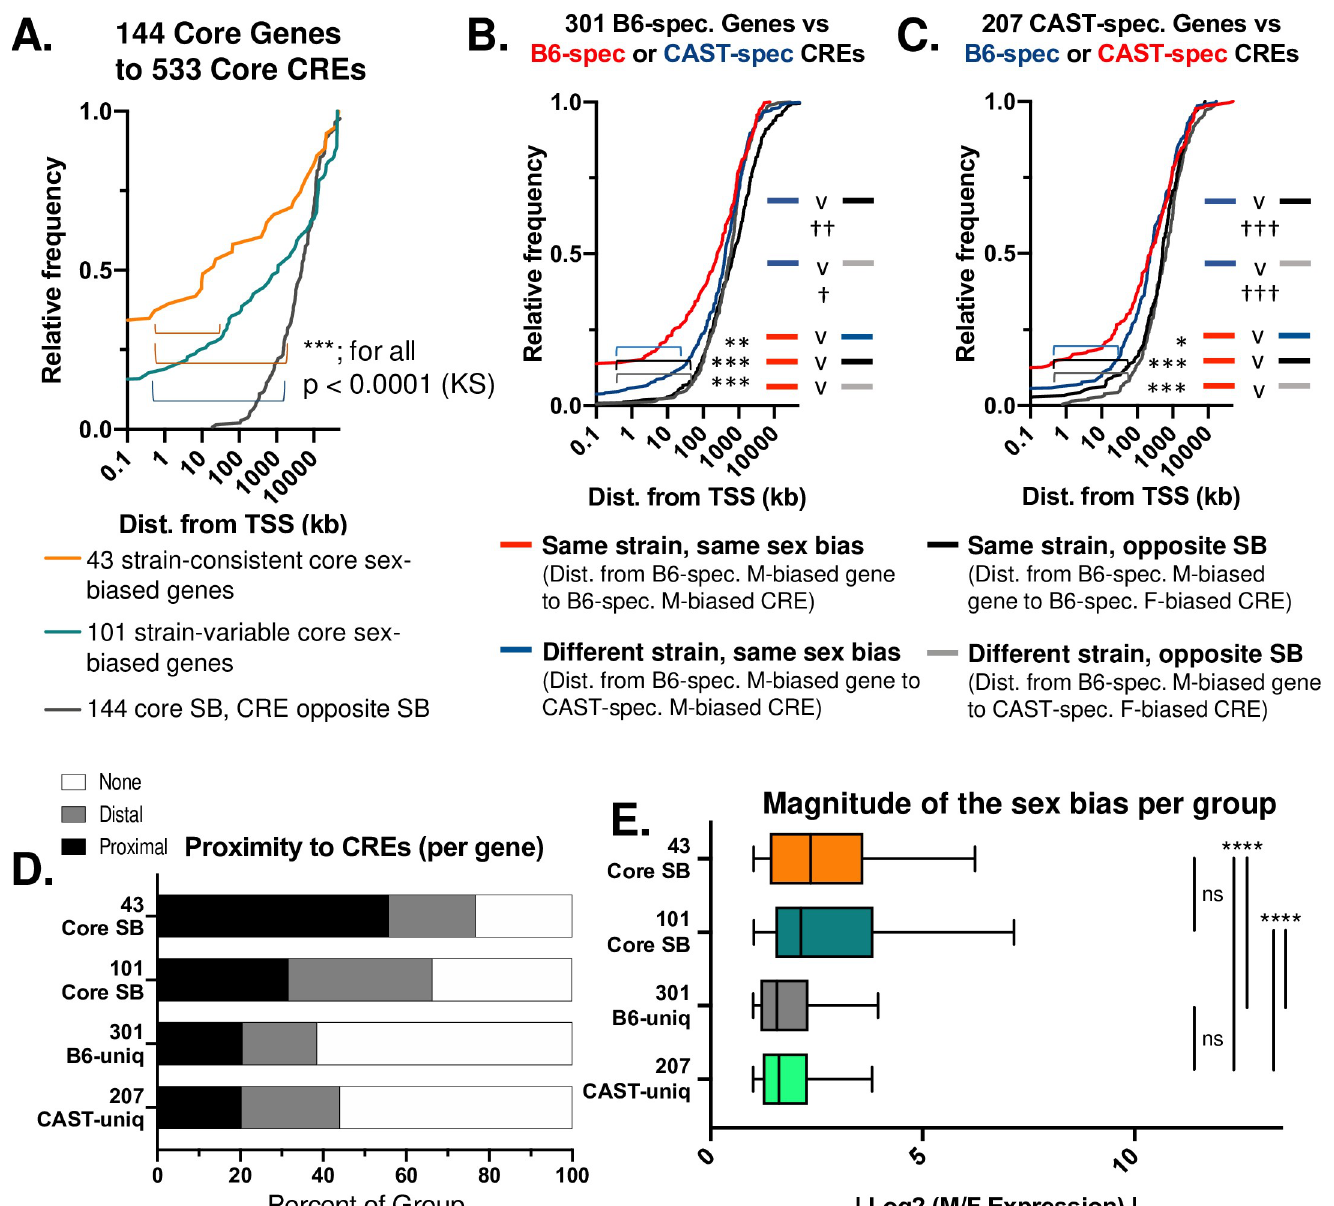
Fig 3. Strain-shared and strain-unique sex-biased cis regulatory elements. A. Cumulative frequency plots of distance from TSS of each gene set to the nearest core, strain-conserved sex-biased CRE with the same sex bias (i.e., distance from TSS of male-biased gene to the nearest male-biased DHS or male-biased H3K27ac peak). Plots are shown for 3 gene sets: 43 core sex-biased genes with strain-conserved expression (Fig 1B clusters MA or FA; orange), 101 core sex-biased genes with strain- variable expression (core sex-biased genes not in Fig 1B clusters MA or FA; teal), and the distance from all 144 core, strain-conserved sex-biased genes to the nearest sex-opposite CRE (e.g. distance from male-biased gene TSS to the nearest female-biased DHS or female-biased H3K27ac peak; gray). See also Sheet A in S1 Table. Significance was assessed by KS test: � , p < 0.05; �� , p < 0.01; ��� , p < 0.001; ns (not significant), p > 0.05. B. Cumulative frequency plot of distance from TSS of the 301 B6-unique sex-biased genes to four lists of cis regulatory elements (sex-biased DHS and sex-biased H3K27ac peaks): (1) B6-specific sex-biased CREs with the same sex-bias (as in panel A), in red; (2) CAST-specific sex-biased CREs with the same sex-bias, in blue; (3) B6-specific sex-biased CREs with opposite sex-bias, in black; (4) CAST-specific sex-biased CREs with opposite sex-bias, in gray. See Sheet C in S1 Table for B6-unique sex-biased genes. Significance, as in A. v, versus. C. Cumulative frequency plots of distance from TSS of 207 CAST-unique sex-biased genes to four lists of CREs (sex-biased DHS or sex-biased H3K27ac peak): (1) CAST-specific sex-biased CREs of the same sex-bias (as in A), in red; (2) B6-specific sex-biased CREs of the same sex-bias, in blue; (3) CAST-specific sex-biased CREs of the opposite sex-bias, in black; (4) B6-specific sex-biased CREs of the opposite sex-bias, in gray. See Sheet D in S1 Table. Significance, as in A. D. Core, strain conserved sex-biased genes are more proximal to similarly sex-biased CREs than strain-unique sex-biased genes. Shown are stacked bar charts representing percent of each group with a sex-biased enhancer of the same directionality that is TSS-proximal ( < 20 kb; black), TSS-distal ( > 20 kb but within the same TAD; gray) or lacking any similarly-sex-biased CREs within the same TAD (none; white). E. Box plot showing sex-bias each gene set group, shown as the absolute value of the log 2 - transformed M/F fold-change values (EdgeR), based on data in S1 Table. Gene sets as in A-C. Significance, as in A.